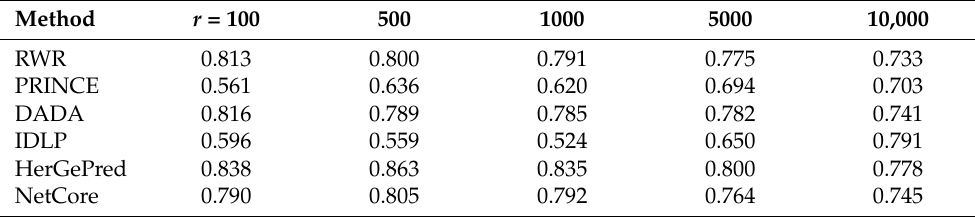
Figure 1. ROC ( a ) and recall ( b ) curves evaluated by gene ranks for disease-gene association predic- tion with known disease-associated genes. Table 3. AUC results evaluated by gene ranks for disease-gene association prediction with known disease genes from